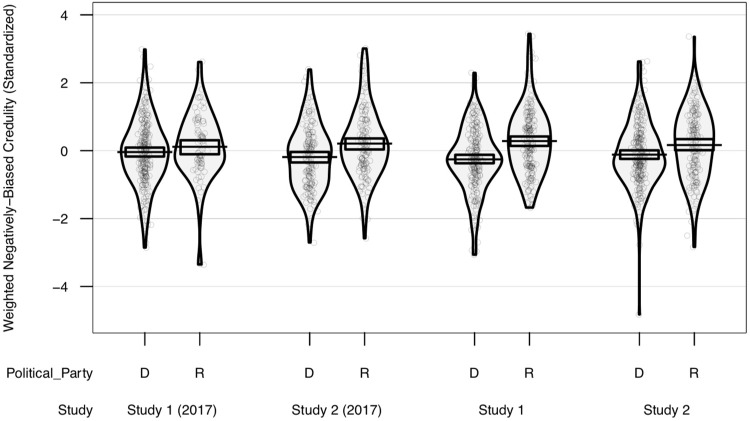
Negatively-biased credulity and political party.Negatively-biased credulity as a function of political party affiliation, comparing current results from Fessler et al.’s 2017 paper [14] with those from the current studies. Scatterplot points are individual scores, jittered along the (meaningless) horizontal axis to reduce overlap. Only data from self-identified Democrats (D) and Republicans (R) included. Beans show smoothed density of data points. Bars and boxes represent means and Bayesian 95% highest density intervals, respectively.